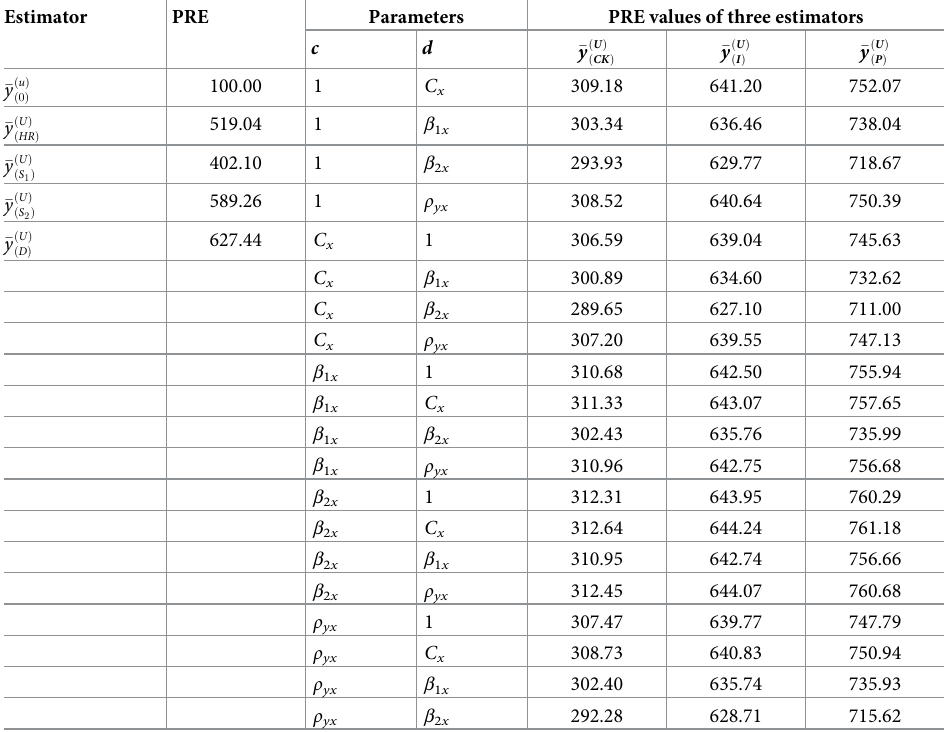
Table 2. Results of different estimators for Population